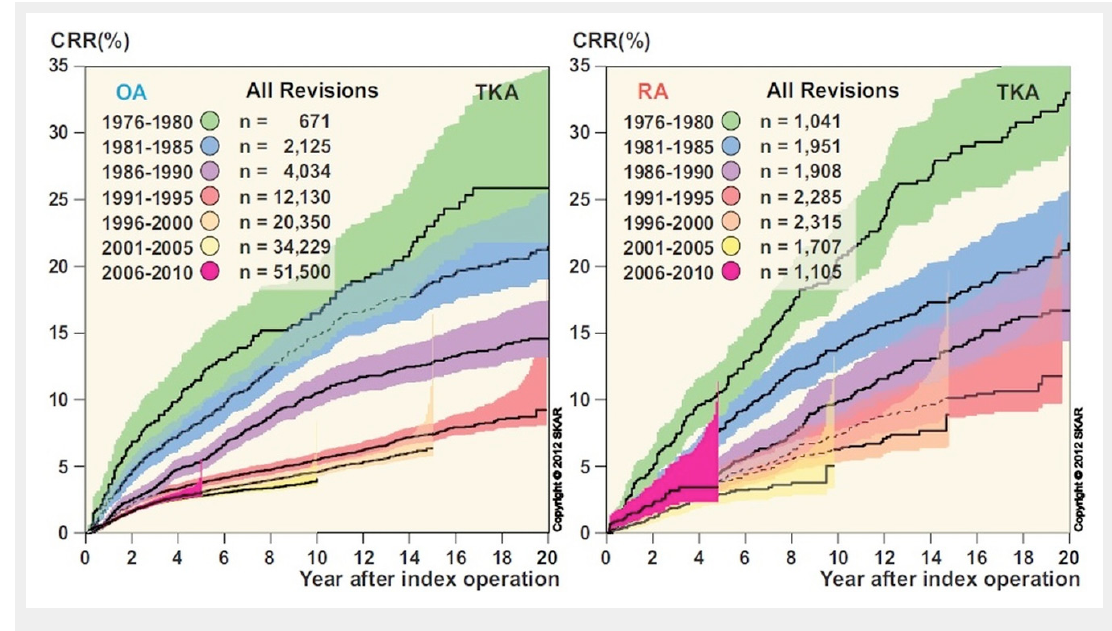
Cumulative revision rates (CRR) after total knee arthroplasty, with separate graphs for osteoarthritis (OA) and rheumatoid arthritis (RA). Reproduced with the kind permission of the Swedish Knee Arthroplasty Register.